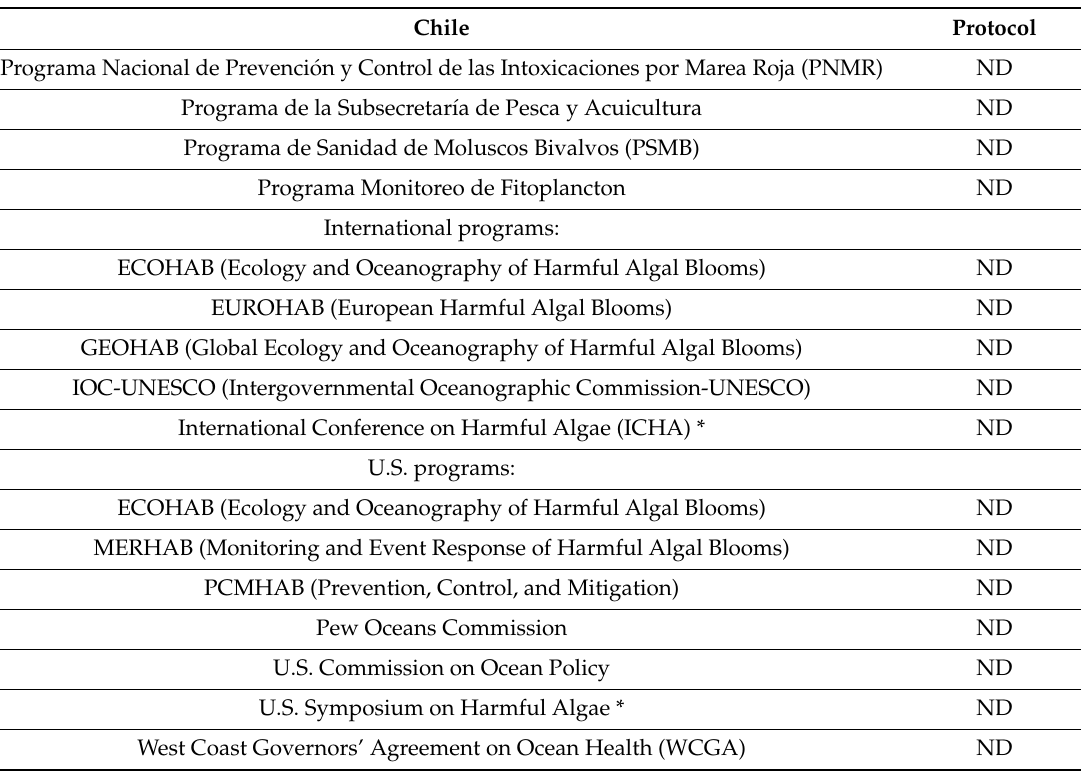
Table A3. List of major HAB programs.